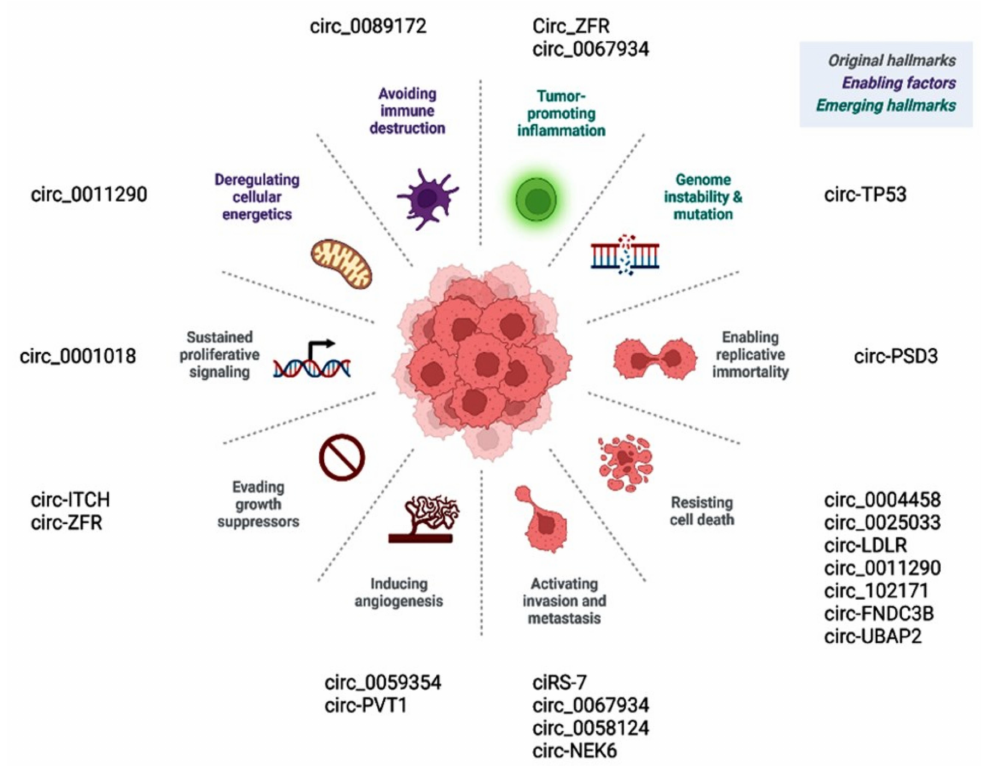
Figure 6. CircRNAs regulate various hallmarks of cancer. Collectively, 34 microRNAs and 51 target genes are known to be deregulated by circRNAs in thyroid cancer. Pathway enrichment analysis of 51 target genes in the reviewed articles demonstrated their role in inflammation mediated by chemokine and cytokine signaling (MAPK1, JAK2, TCF3, STAT1, RAC1, CXCR1, and p38), the Wnt signaling pathway (TCF3, PRKC1, TP53, FSTL1, FZD8, and LEF1), angiogenesis (MAPK1, FGFR1, VEGFA, p38, STAT1, and PRKCI), CCKR signaling map (MAPK1, JAK1, TCF4, MP9, p38, and RAC1), and the PDGF signaling pathway (MAPK1, JAK2, mTOR < STAT1, and p38) (Figure 7).